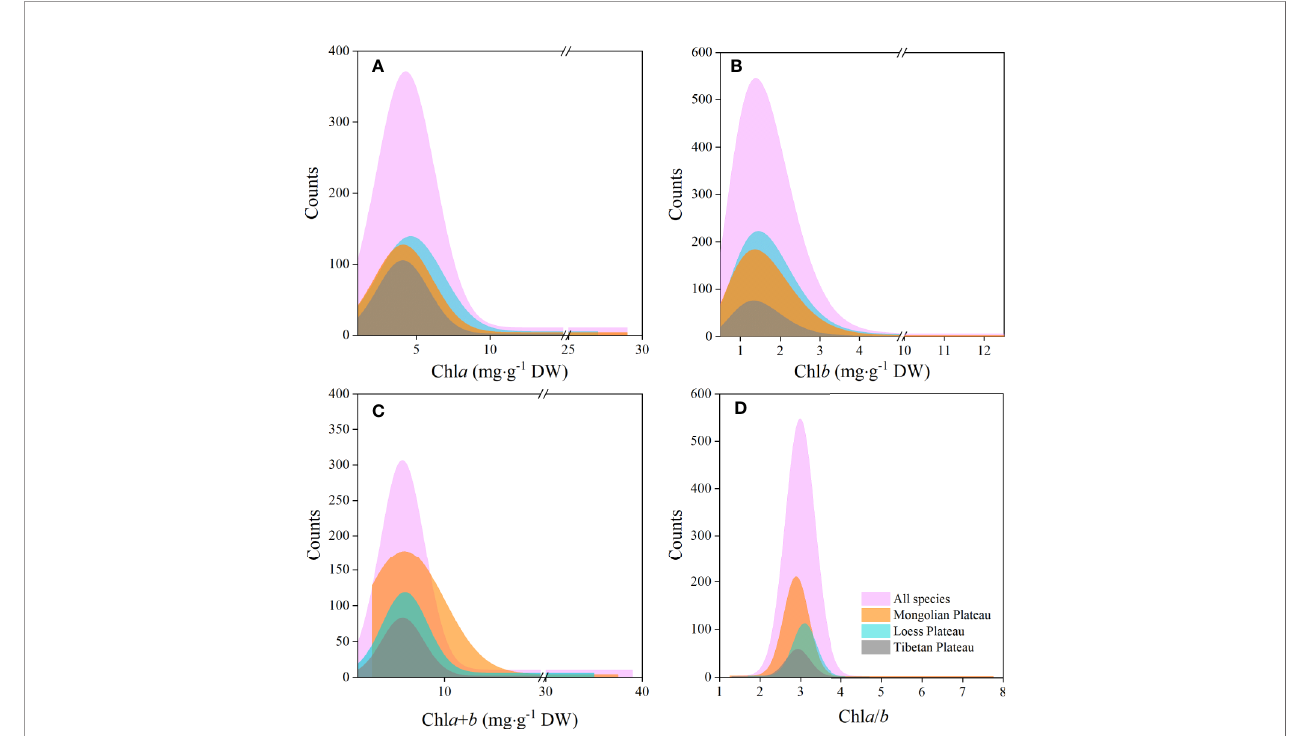
FIGURE 2 | Frequency distributions of chlorophyll concentrations and ratio of the whole northern hemisphere grassland transects and three plateaus, respectively. (A – D) denote distributions of chl a , chl b , chl a + b , and chl a / b ,